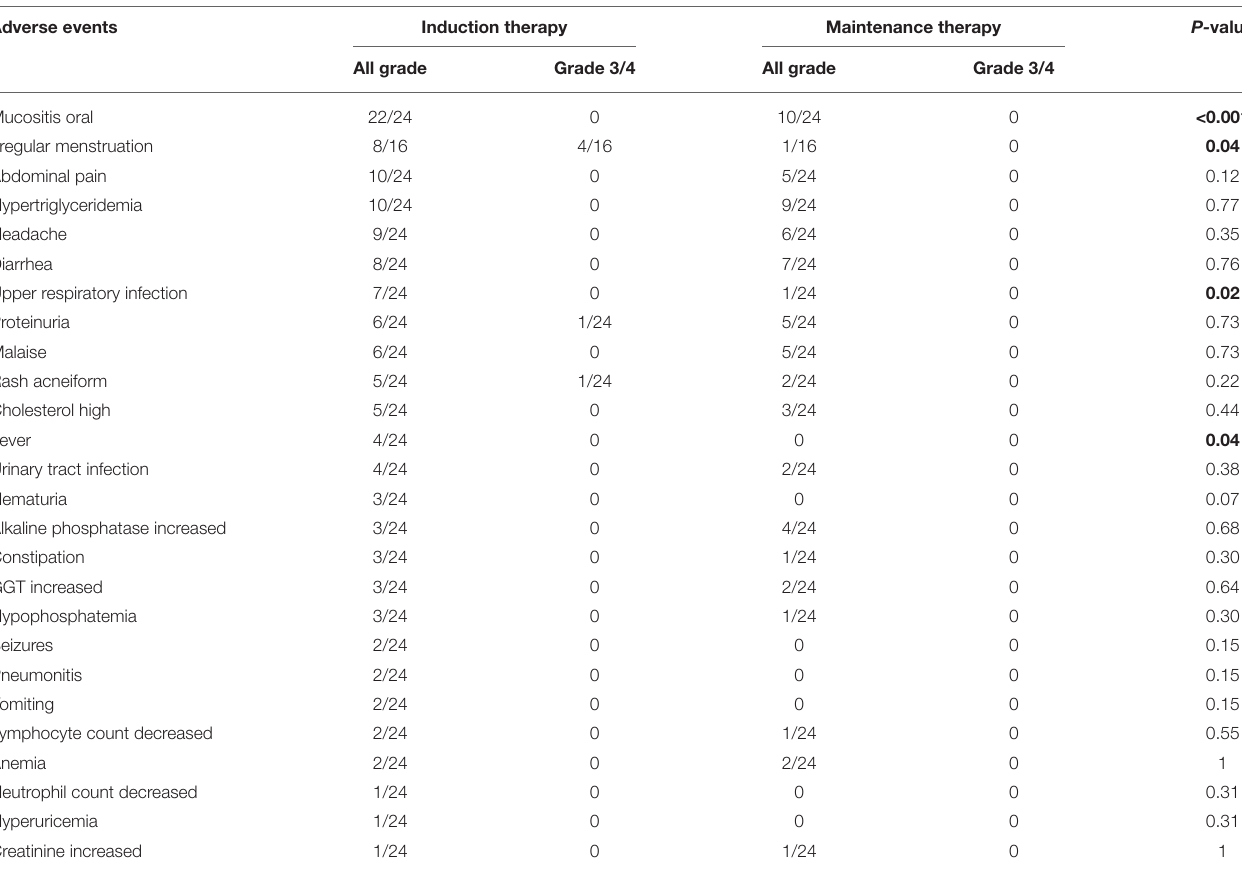
TABLE 5 | Adverse events associated with everolimus in the study group during induction and maintenance